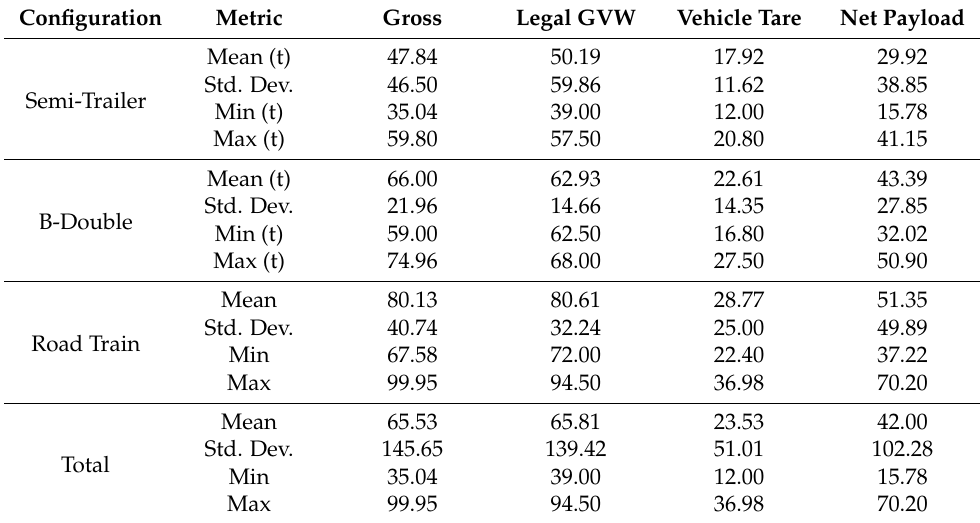
Table 3. Descriptive statistics of recorded parameters for each truck load by